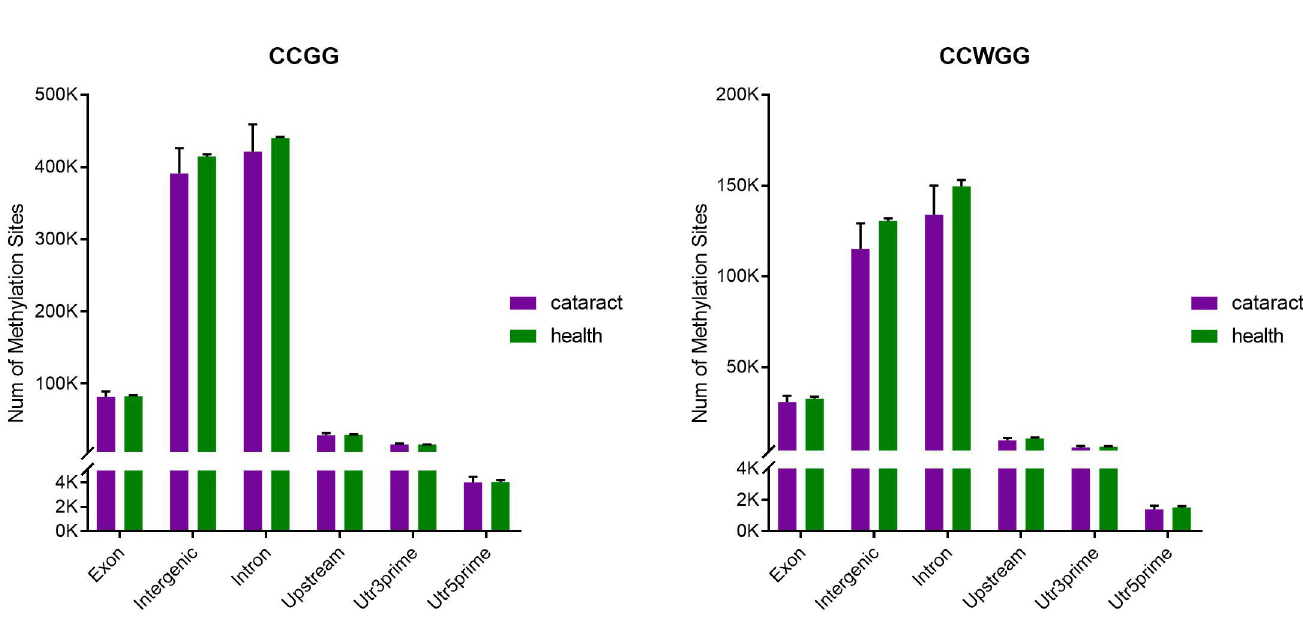
Fig 1. Distribution of methylation